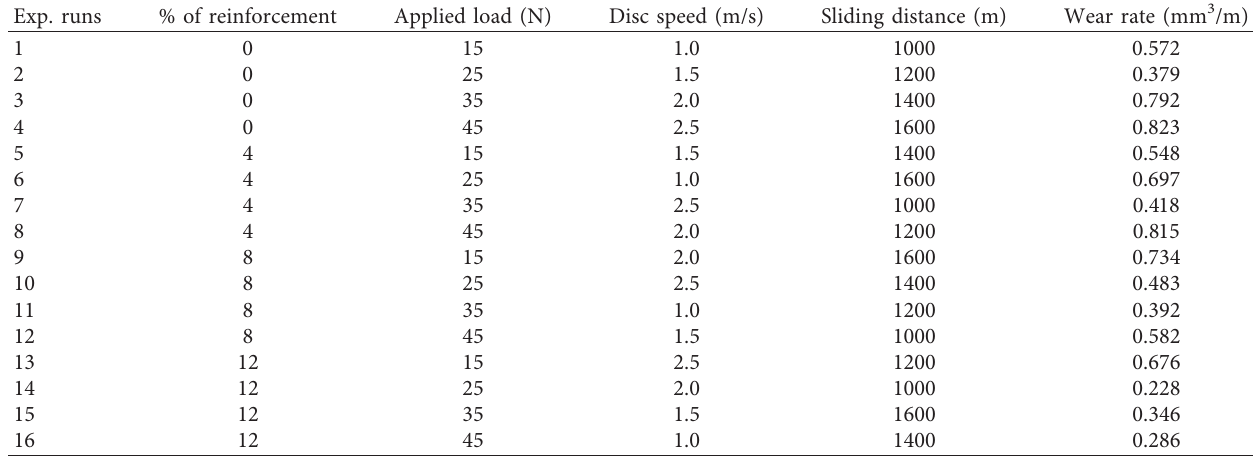
Table 4: Experimental summary of wear test.